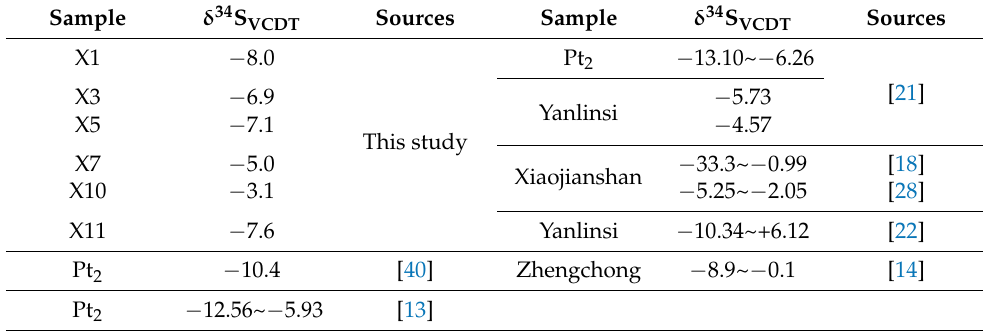
Table 3. Sulfur isotopic compositions of pyrite from Xiaojiashan gold deposit (‰).